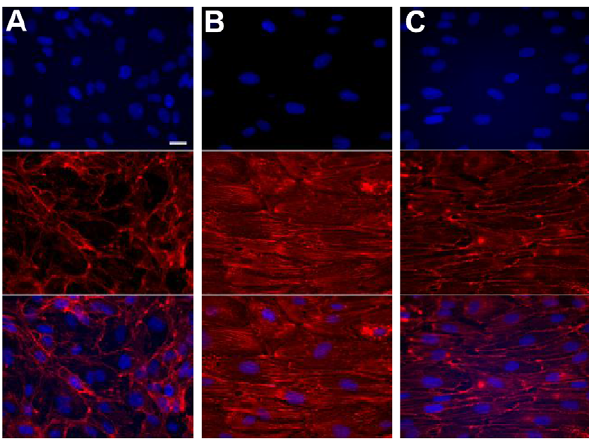
Figure 3. Cytoskeletal morphology of flow-conditioned endo- thelial cells. Endothelial cell monolayers were grown to confluence and cultured under static conditions (A), steady flow (B), or physiological flow (C) for 24 hours. Monolayers were subsequently fixed and co-stained with rhodamine phalloidin (middle row) and DAPI (top row) in order to visualize f-actin and cell nuclei, respectively. Shown are representative images (40x) from each condition. Applying shear stress resulted in cytoskeletal alignment of endothelial cells in the flow direction (horizontally left to right). Scale bar: 20 microns.